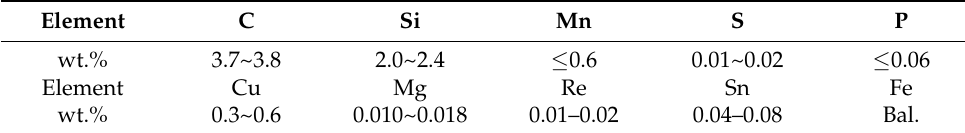
Table 1. Nominal chemical compositions of compacted graphite